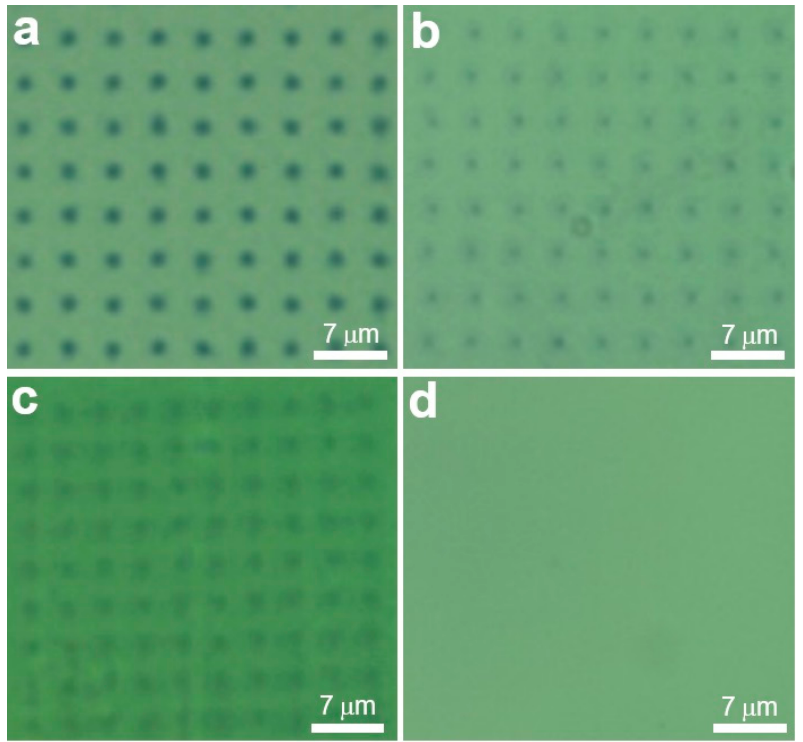
Figure 4. Representative optical microscopy images (40 × magnification) for immobilisation experiments on arrays with capture DNA-AuNPs and genomic DNA extracted from G. boninense mycelia, using ( a ) 400 ng ( b ) 160 ng, and ( c ) 30 ng and ( d ) 225 ng of non-complementary DNA extracted from soya bean. Genomic DNA was mixed with the DNA-AuNPs at 95 ◦ C for 5 min followed by 1 h cooling at RT to allow hybridisation. The mixture was then applied to arrays for 3 h at 30 ◦ C followed by 10 min cooling at RT prior to